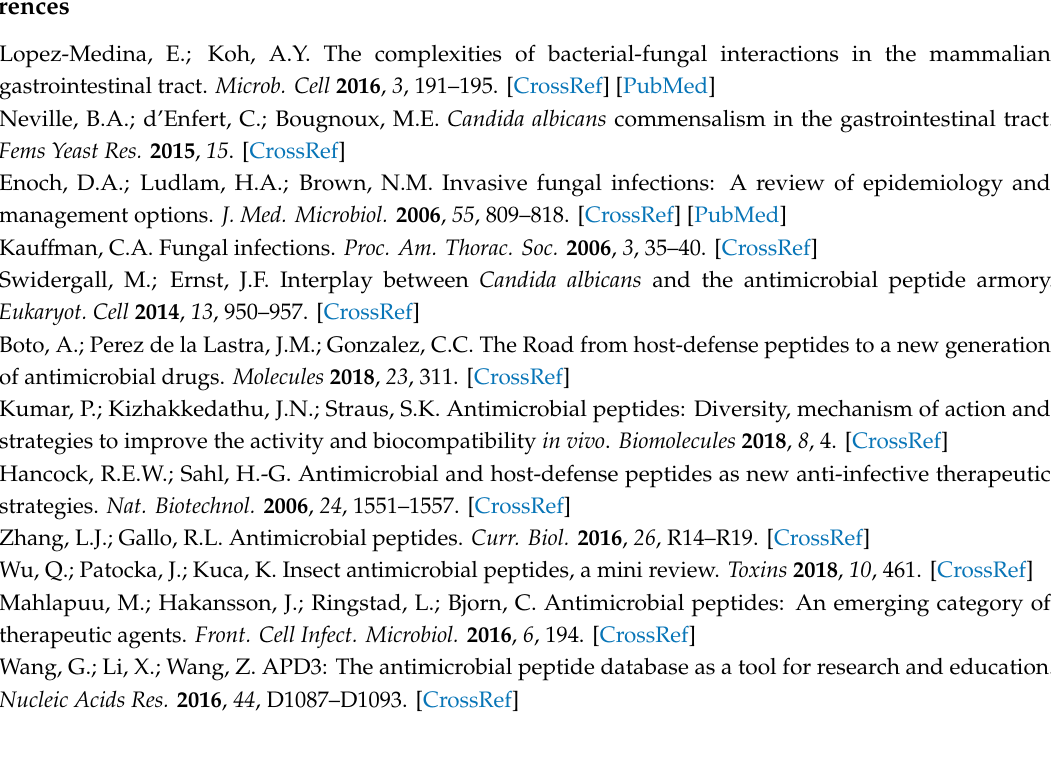
Figure S1: The activity of hep 25 against various clinical isolates of C. albicans and non- albicans Candida spp. Figure S2: Mitochondrial depolarization detected with DiOC6(3). Figure S3: Mitochondrial depolarization detected by TMRM. Figure S4. The e ff ect of 2 mM BCS on the candidacidal activity of hep 25. Table S1: Clinical isolates of Candida spp. used in this study. Table S2: Minimal fungicidal concentrations (MFCs) of hep 25 against C . albicans and non- albicans Candida clinical